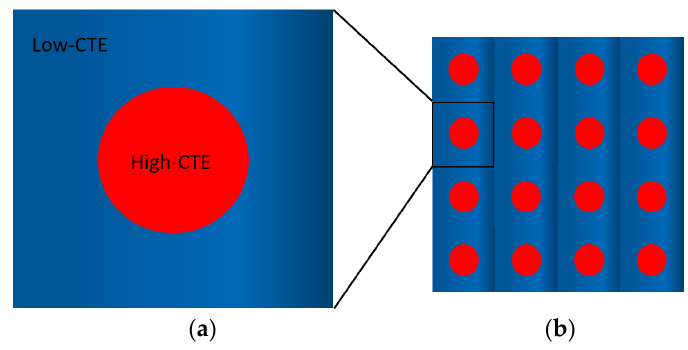
Figure 2. A concept of a single-unit cell ( a ) and a 4 × 4 cell lattice structure ( b ).